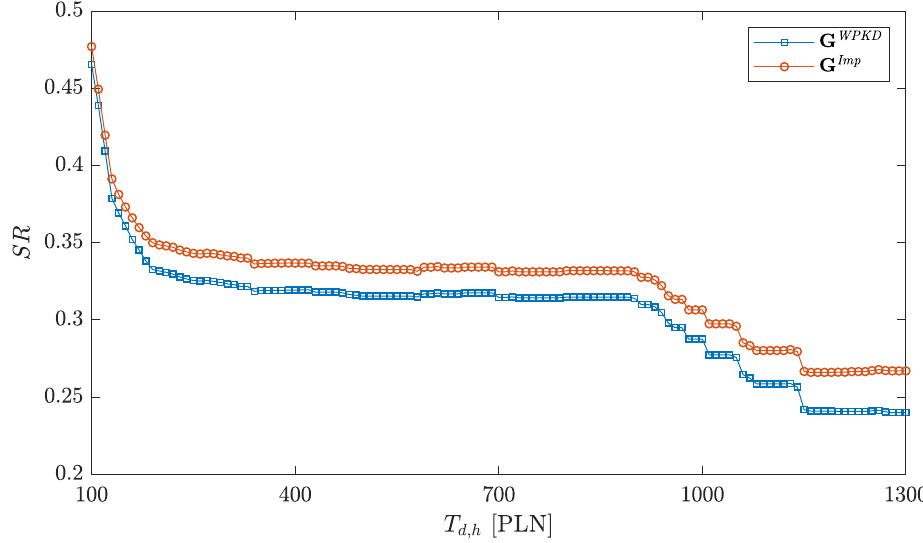
Figure 6. Sharpe ratio SR as a function of the tolerance threshold T = T d , h for commission C = 4.25 PLN. Clearly, the lower the tolerance threshold, i.e., the more risk is transferred to the RES producer, the higher the Sharpe ratio. Note also, that the G Imp strategies are more profitable than the corresponding G WPKD T strategies for the whole range of tolerance thresholds